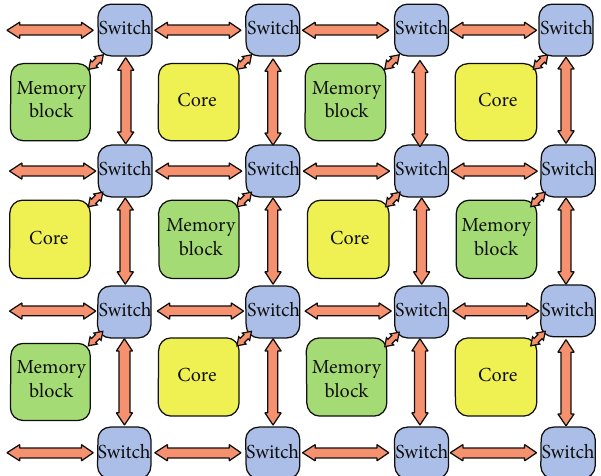
Figure 5: Example NoC consisting of a mesh of switches and resources (cores and memory